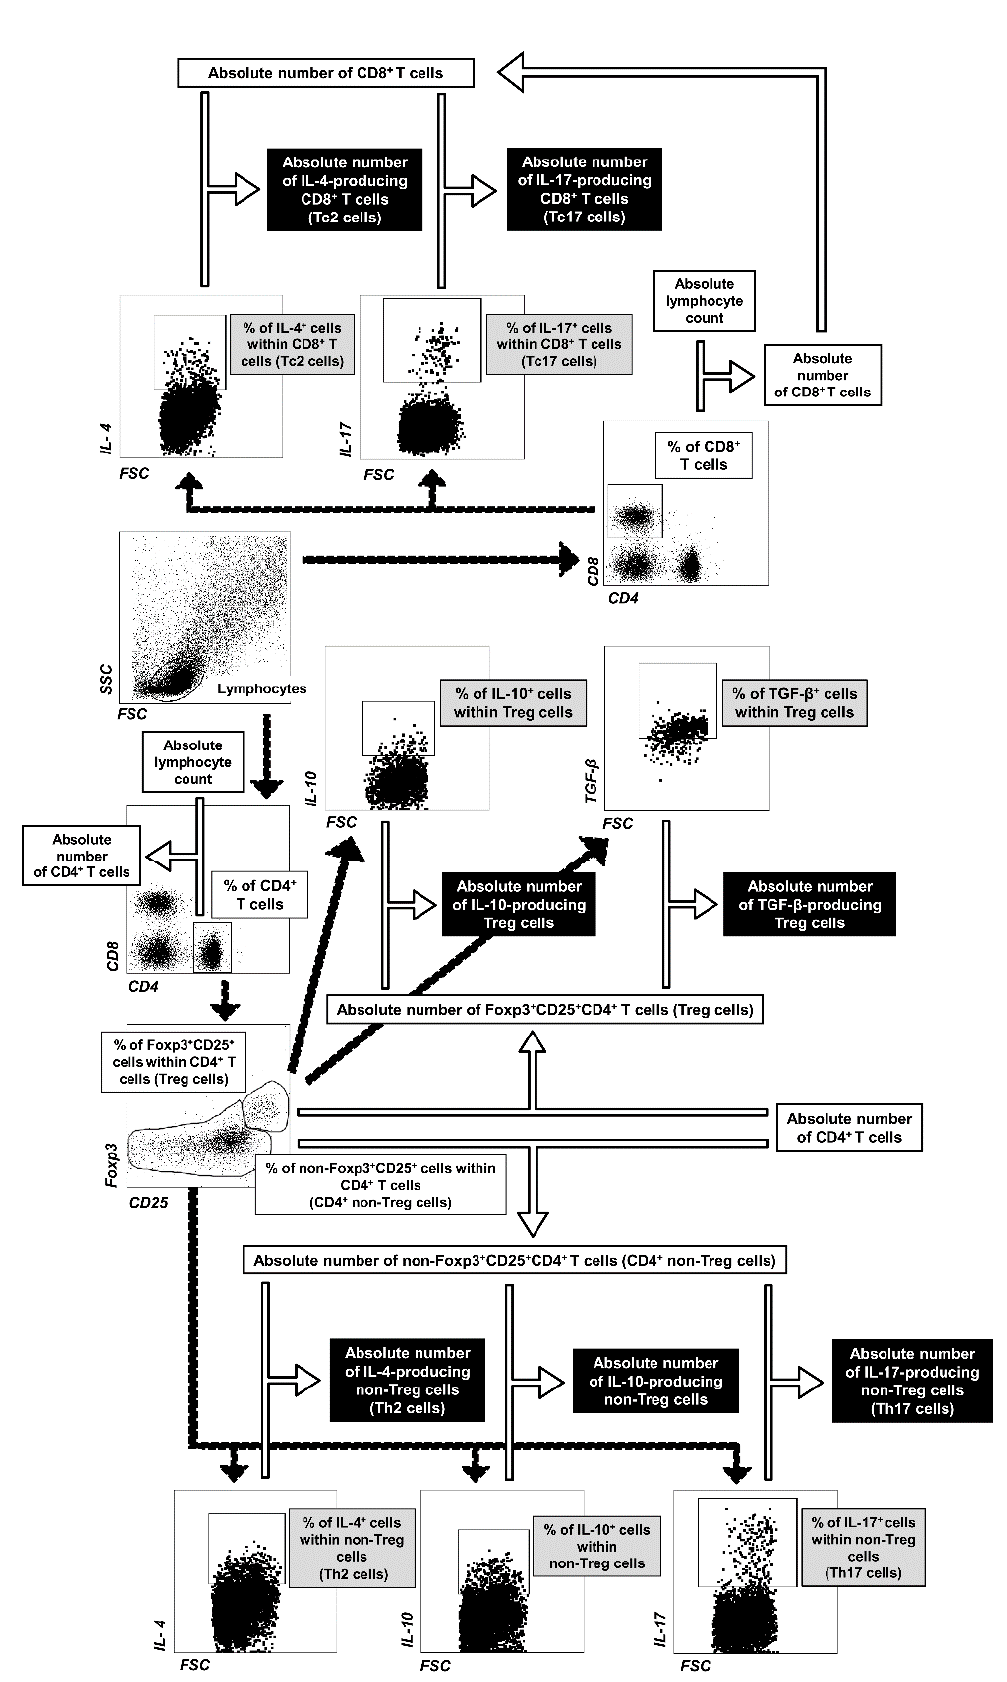
Figure 8. Gating strategy for flow cytometric data analysis and calculation of the absolute cell counts of lymphocyte subsets. Lymphocytes were identified based on forward and side scatter (FSC/SSC) properties, and then gated for expression of CD4 or CD8 surface receptors. CD4 + T cells were analyzed for expression/co-expression of CD25 and Foxp3. On this basis, Treg (Foxp3 + CD25 + CD4 + ) and non-Treg (the remaining CD4 + T cells, i.e., non-Foxp3 + CD25 + CD4 + T cells) cells were distinguished. Subsequently, IL-4-, IL-10-, IL-17- and TGF- β -producing cells were iden- tified within particular cell subsets. Absolute cell counts of lymphocyte subsets (i.e., number of